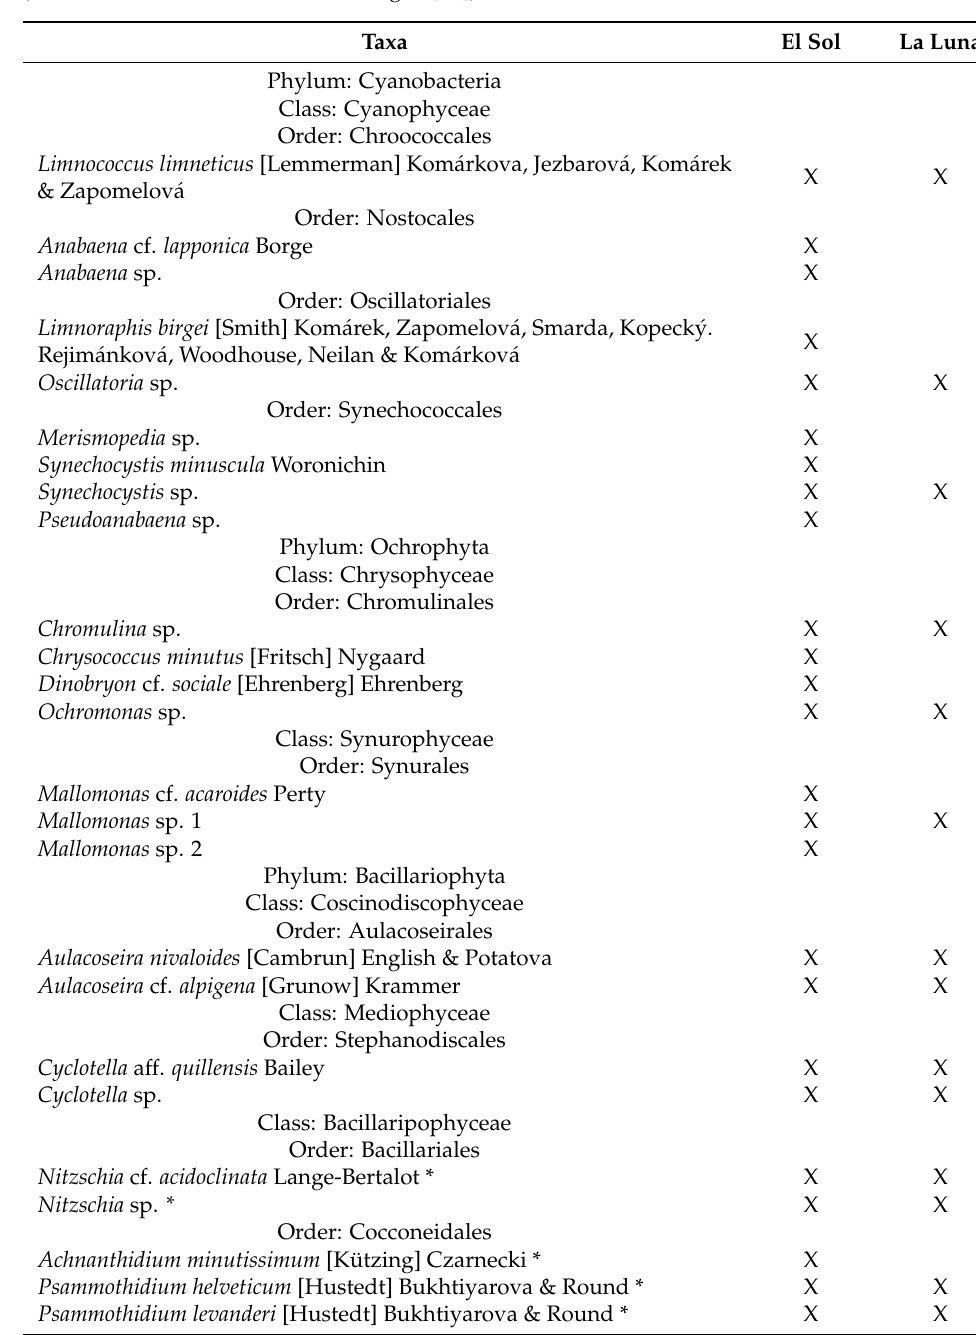
Table 2. Phytoplankton taxonomic list of HML El Sol and La Luna, Nevado de Toluca. According to AlgaeBase [42]. (X indicates the species presence. * Indicates tychoplanktonic morphospecies). (Navicula NTA and N. NTB according to